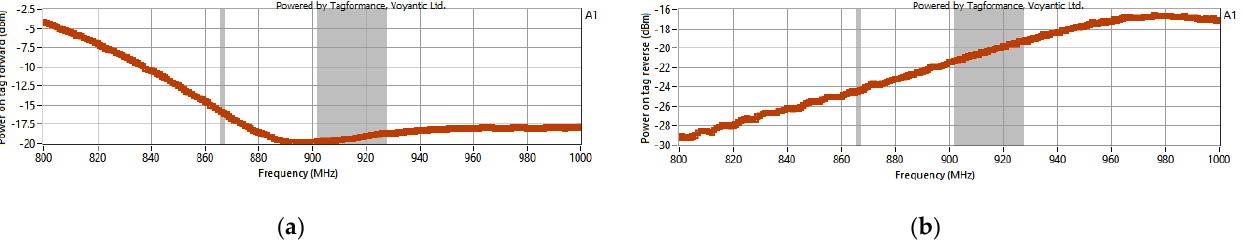
Figure 20. Exemplary sensitivity (for A1 sample) of energy ( a ) and data ( b ) transmission on RFIDtex